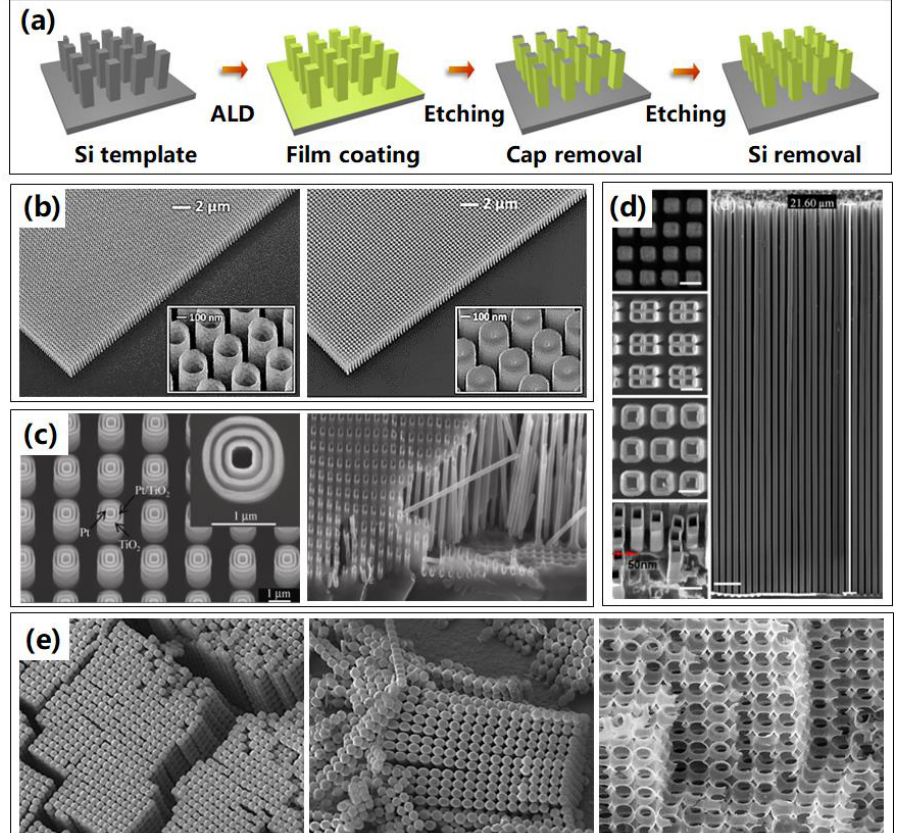
Figure 3. Representative 3D nanostructures fabricated by ALA method through Si templates. ( a ) Process routine of 3D nanostructures based on Si templates by ALA method. ( b ) Titled scanning electron microscope (SEM) images of the 3D metamaterial structures: Al-doped ZnO (AZO) nano- tubes and nanopillars. The insets show an enlarged view of the metamaterials. Reprinted from [32], copyright 2017, with permission from Optical Society of America. ( c ) Multi-walled nested nanotube structures with alternating open annular layers after removal via chemical etching of two ALD Al 2 O 3 sacrificial spacer layers, cleaved Si template highlighting that ALD Pt has infiltrated up to 90 µm deep into the bottom of the porous Si template. Reprinted with permission from Ref. [35]. Copyright 2011 Springer. ( d ) Top view SEM image of the Si nanostructures after Al 2 O 3 film deposition by ALD, and SEM images of the top, cross-section, and tilted views of the generated Al 2 O 3 nanotube arrays resulting from the sidewall transfer MacEtch process. Reprinted with permission from Ref. [36]. Copyright 2020 MDPI. ( e ) An array of hollow TiO 2 micro-pearl chains viewed from the bottom and the side, and enlarged SEM images of TiO 2 porous network structures. Reprinted with permission from Ref. [37]. Copyright 2008 Springer.